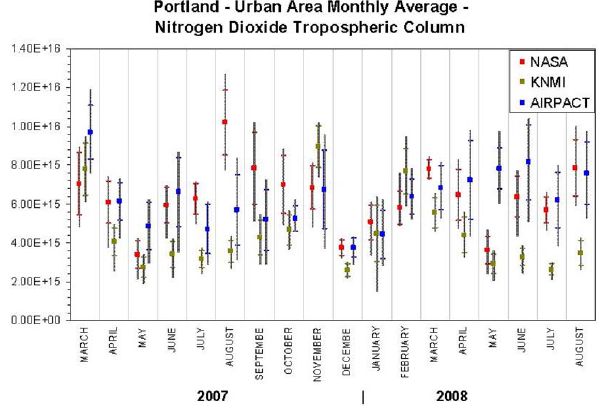
Fig. 8. Monthly Average NO 2 for Vancouver, British Columbia over 18 months. The bars show standard deviation of spatial varia- tion over a 720km 2 area (5 AIRPACT pixels) while the whiskers show the extent of the maximum and minimum. Values are in molecules per square centimeter.